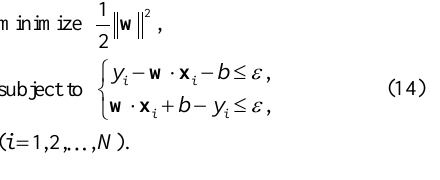
gradient-based Levenberg-Marquardt backpropagation is used during ANN training. The tansig function is employed in the hidden layer. For the output layer, logsig and tansig functions are alternatively assigned in order to investigate their effect on the estimated FSC